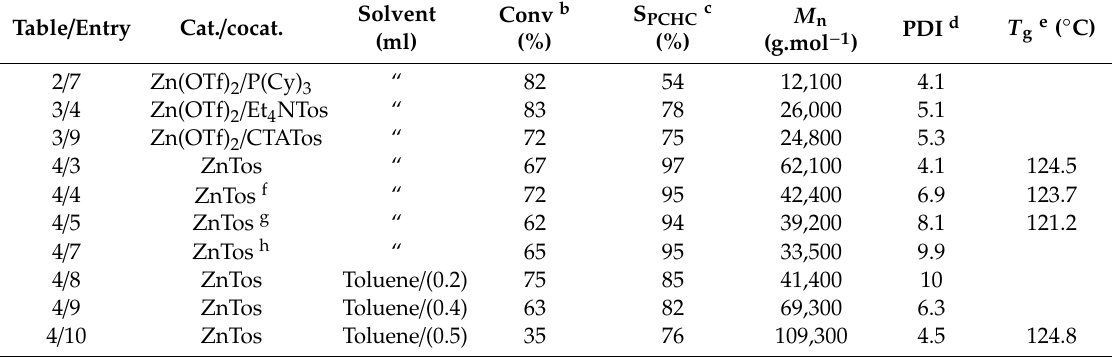
Table 5. GPC data for the PCHC samples prepared using catalysts based on Zn(OTf) 2 / cocatalysts a . Table / Entry Cat. /